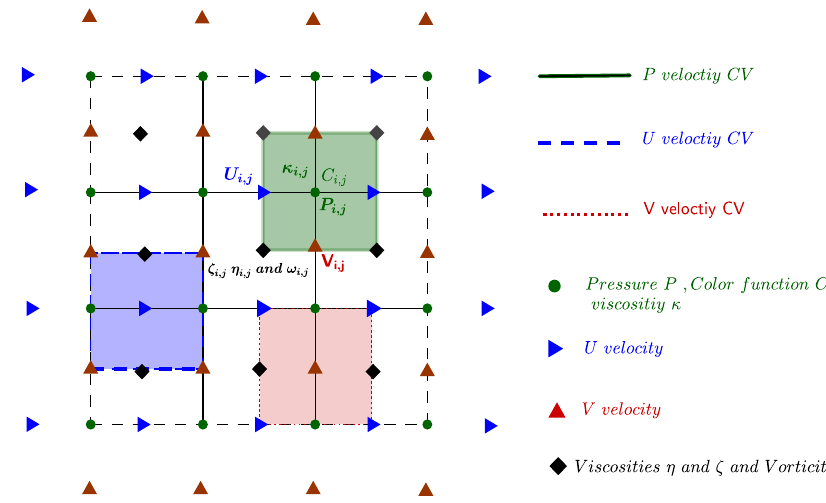
Figure 1. Staggered pressure and velocity unknowns in the global domain. the pressure p i , j , the elon- gation viscosity κ i , j and the colour function C i , j are located at the nodes of the Eulerian grid, the hori- zontal velocity u i , j is defined on the left and right sides of the control volume (in green) associated with p i , j and vertical velocity v i , j is defined on the bottom and top sides of the control volume associated with p i , j , the vorticity ω i , j , and the rotational η i , j and ζ i , j shear viscosities are located at the vertices of the control volume associated with p i , j